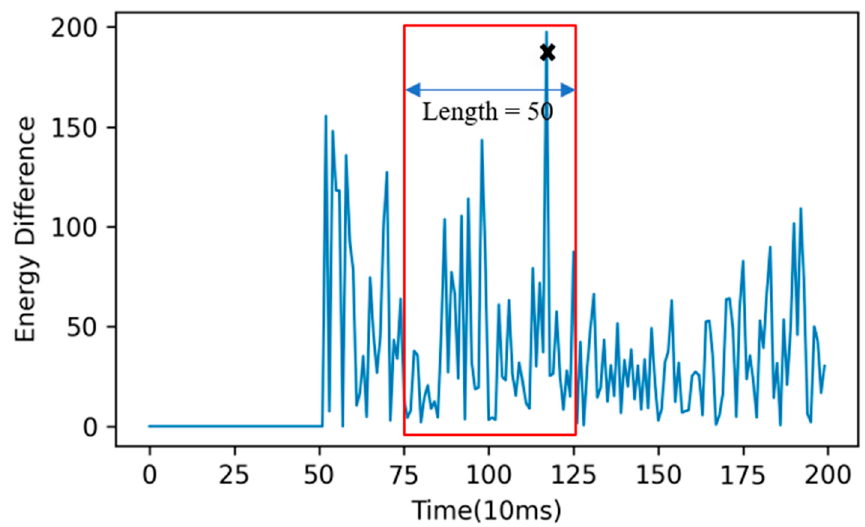
Figure 3. Sliding window filtering used for searching for the maximum energy difference to obtain breakpoints. The red box is our sliding window of 50 min length.